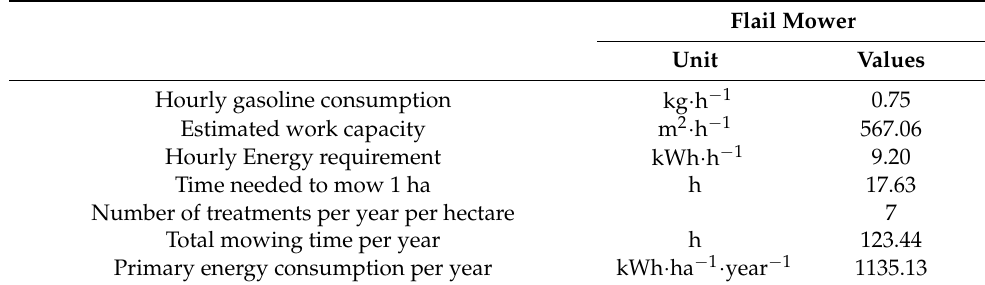
Table 5. Estimated energy consumption of the flail mower.